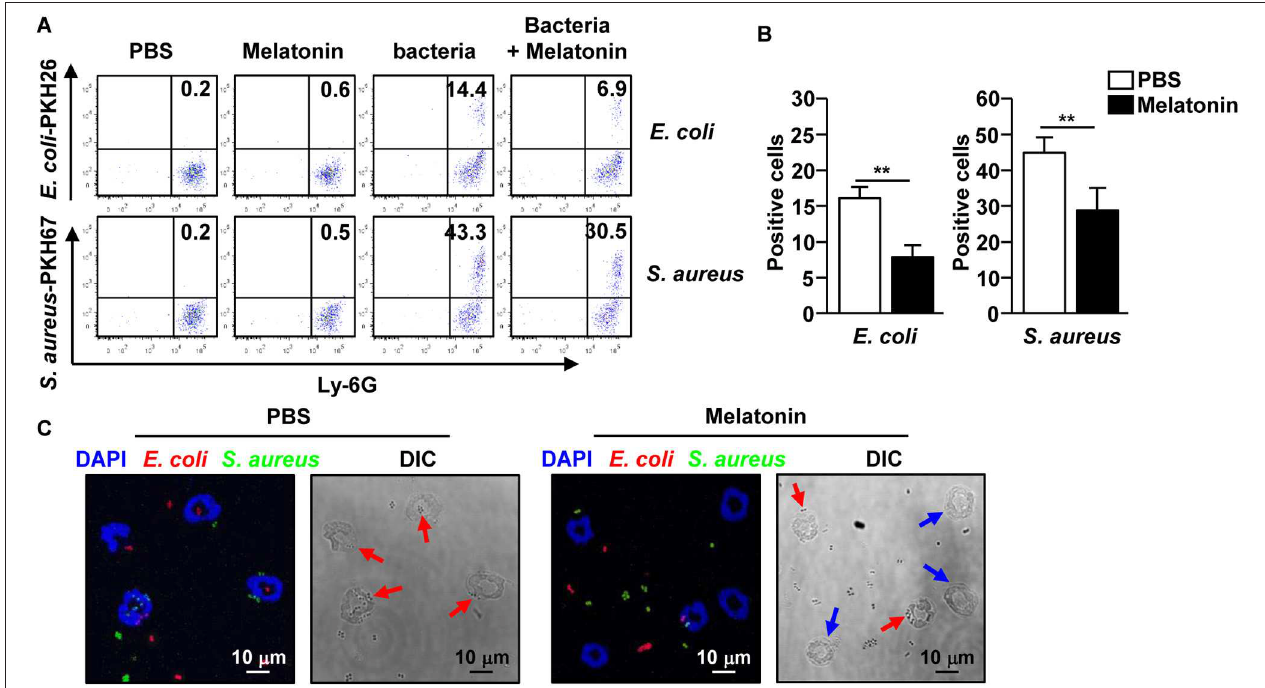
FIGURE 4 | Melatonin suppressed the phagocytic activity in neutrophils. (A) Phagocytosis of PKH26-labeled E. coli and PKH67-labeled S. aureus by neutrophils was analyzed by flow cytometry. (B) The mean number of E. coli (left panel) and S. aureus (right panel) phagocytosed by the neutrophils are shown. (C) Isolated neutrophils were co-cultured with PKH26-labeled E. coli (red color) and PKH67-labeled S. aureus (green color) for 1h, and the cells were spun down on a glass slide using a cytospin. Phagocytic neutrophils were observed used a confocal microscope. Red arrows indicate the phagocytic neutrophils and blue arrows indicate non-phagocytic neutrophils. Data represent the average of six independent samples for each group (three samples per experiment, total of two independent experiments), ** p <